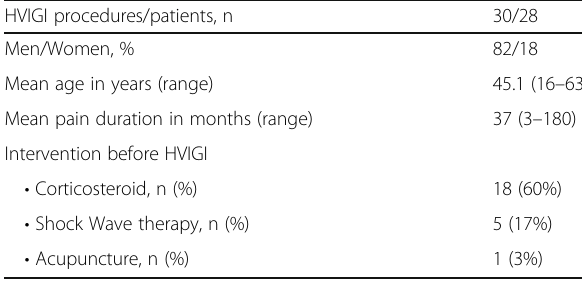
Table 1 Patients demography